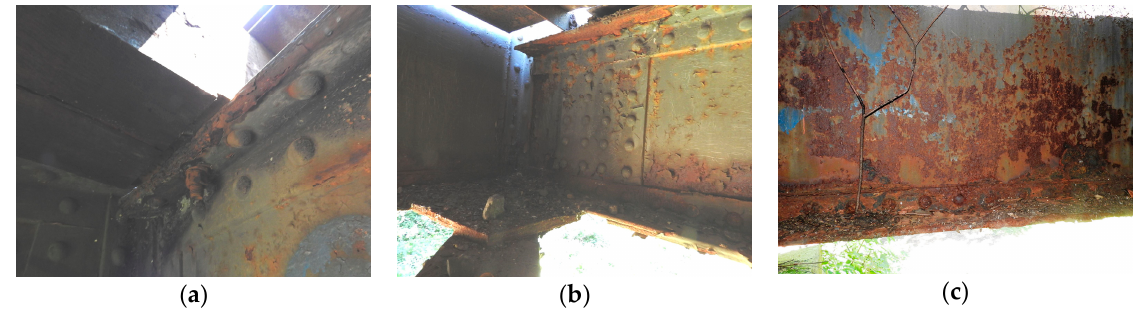
Figure 7. Examples of the degradation of the elements of Bridge 2: ( a ) local severe degradations of the top flange under the sleeper contact; ( b ) detail of the joint where the crossbeam, main girder, and bottom bracing are connected; ( c ) main girder; strong corrosion of the bottom flange and the bottom part of the girder web.